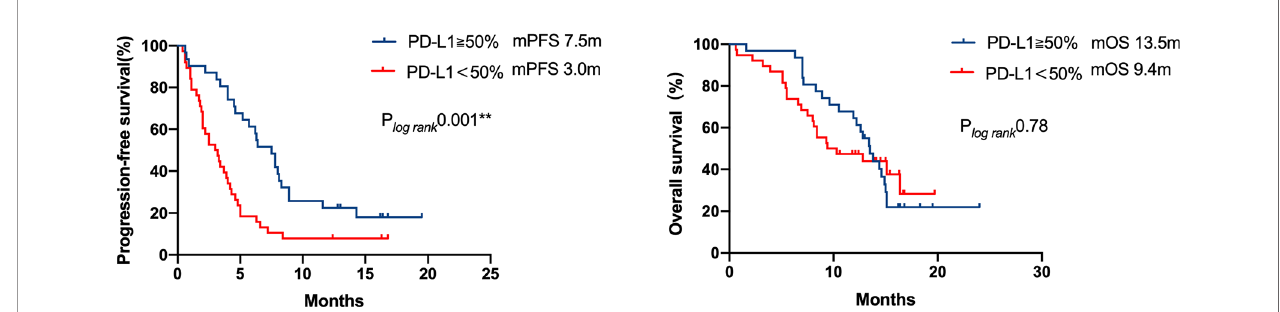
FIGURE 4 | Kaplan – Meier curves of progression-free survival and overall survival of patients with differential PD-L1 expression. A signi fi cant PFS bene fi t was observed in patients with strong positive PD-L1 expression (TPS ≥ 50%) compared with that in patients with a lower PD-L1 expression (TPS < 50%) (7.5 months vs 3.0 months, respectively, P = 0.001), but the difference in OS was not statistically signi fi cant.